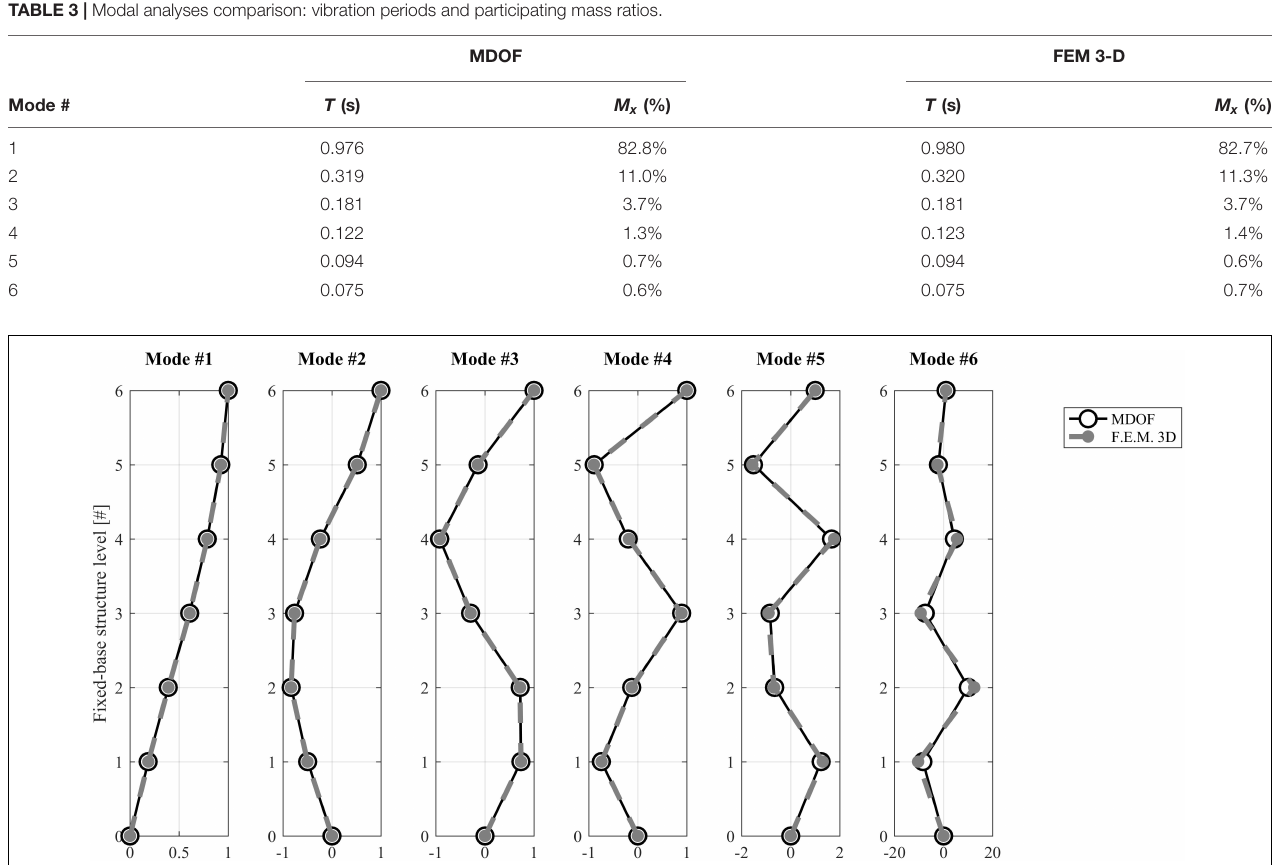
FIGURE 6 | Modal analyses comparison: modal shapes